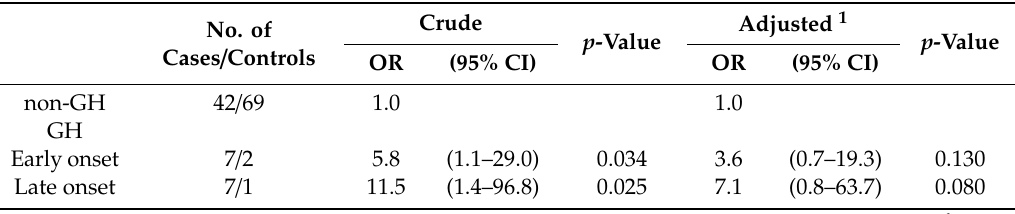
Table 3. Risks of hypertension according to timing of GH